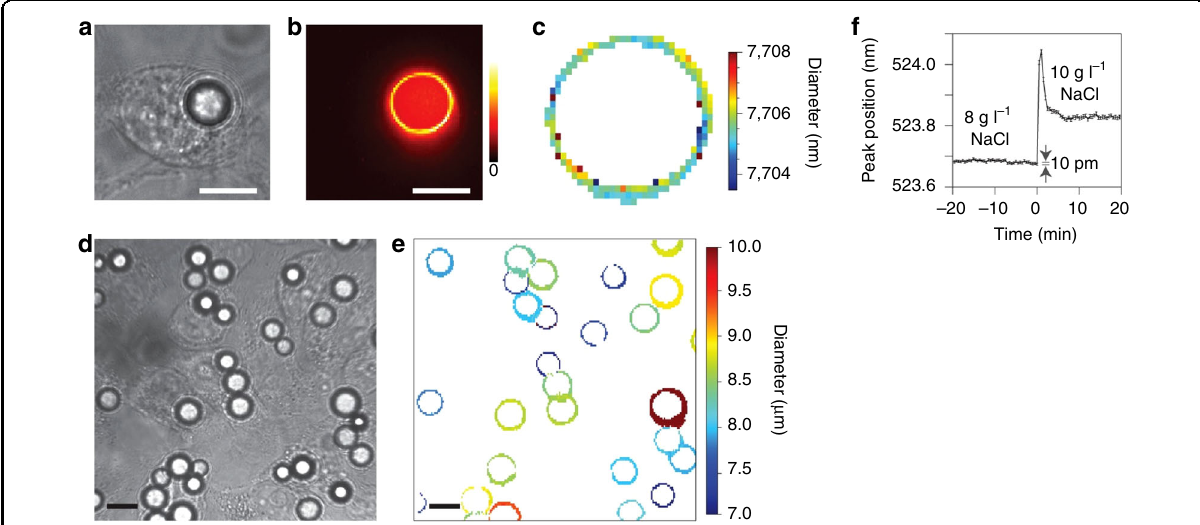
Fig. 8 Intracellular microcavities used for tagging and intracellular sensing of relevant parameters in HeLa cells. a Bright- fi eld image of a HeLa cell after internalisation of a polystyrene fl uorescent bead. b Processed image of the cell in ( a ), where the false-colour intensity corresponds to the oscillating WGMs. c Calculated single-bead diameter map from confocal hyperspectral images corresponding to WGM output. d , e Images of bead-containing HeLa cells ( d ), and corresponding bead diameter map ( e ). f Time evolution of the resonant peak position for a bead inside a HeLa cell upon the addition of sodium chloride at t = 0; such exposure to a hypertonic solution produces cell volume shrinkage, which in turn causes the concentrations in the cytoplasm to vary, affecting the refractive index, which produces a shift in the peak wavelength. Scale bars 10 μ m. Reproduced from ref.